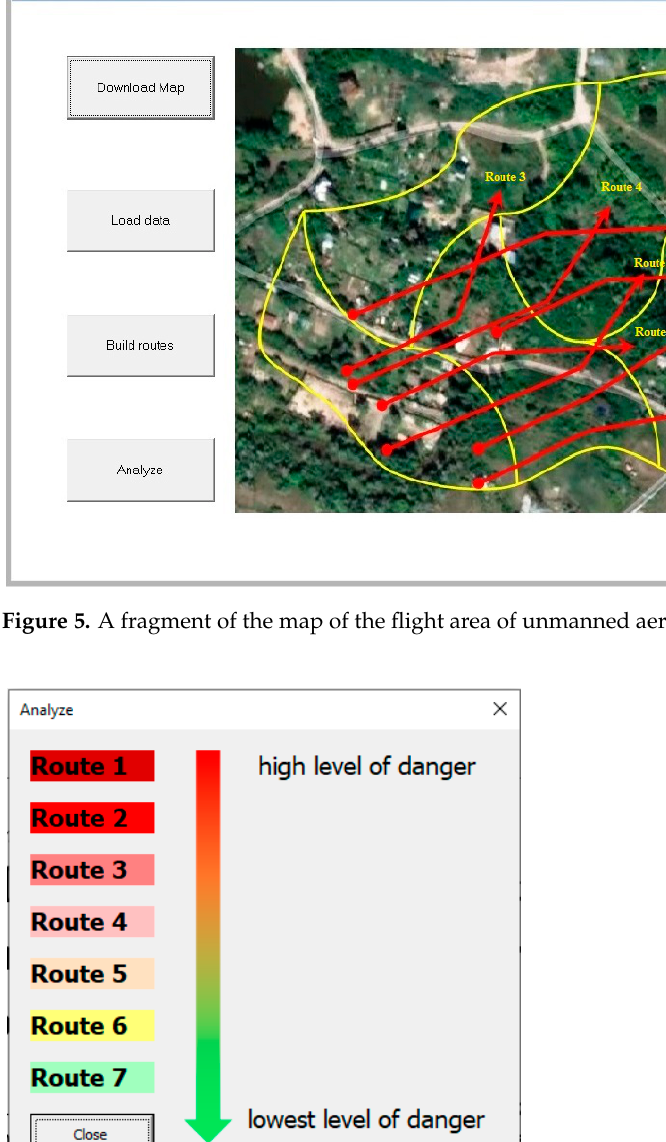
Figure 5. A fragment of the map of the flight area of unmanned aerial vehicles.